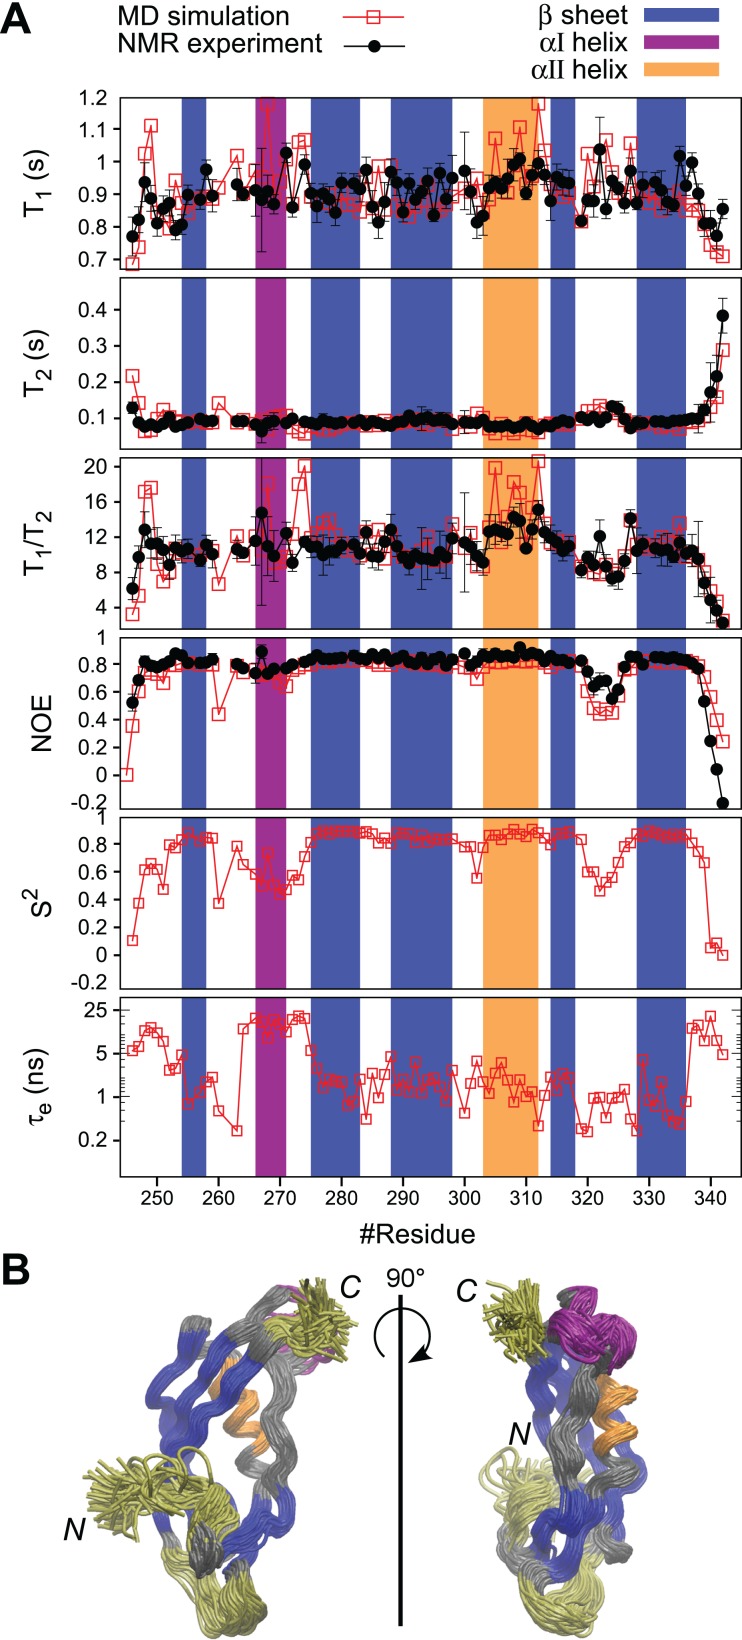
MD simulation of PaTonB-96 and comparison with the experimental data.(A) The comparison of the experimental and simulated 15N relaxation parameters and the internal motions presented by S2 and te obtained from the MD simulation. The regions for β-sheets, αI, and αII are highlighted in blue, purple, and orange, respectively. (B) A superposition of snapshots of the structure from the MD simulation trajectory indicating conformational fluctuations during the MD simulation. The residues with enhanced flexibilities are colored in yellow. The aI-helix with orientation fluctuations is colored in purple. Rotational diffusion coefficient values obtained from the MD simulation of the experimental spin relaxation data are, Dxx = 1.51 ± 0.01, Dyy = 1.72 ± 0.03, and Dyy = 3.79 ± 0.03 (rad2·107/s). These result in Dav = (Dxx + Dyy + Dzz)/3 = 2.3 ± 0.02 (rad2·107/s), τc = (6Dav)–1 = 7.2 ± 0.02 (ns), A = 2Dzz−(Dyy + Dxx) = 4.4 and R = Dyy−Dxx = 0.2, where A is the axiality and R is the rhombicity. The overlay of the trajectories was produced by vmd (Humphrey, Dalke & Schulten, 1996).